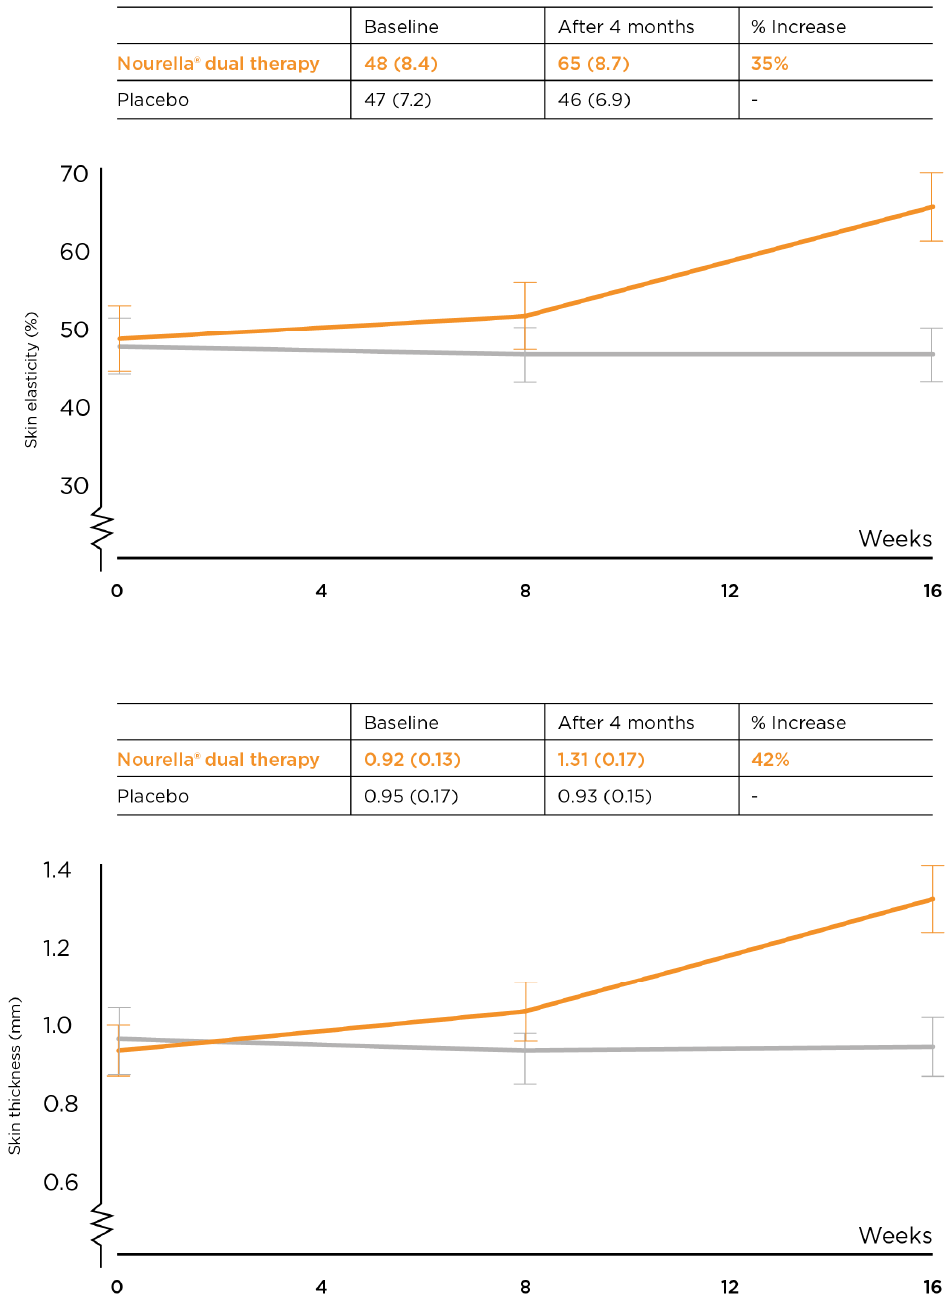
Figure 3. Mean skin elasticity ( up ) and thickness index ( down ) (measured objectively on both sides of the face in duplicates) in 60 individuals randomly assigned at a 1:1 ratio to receive either oral proteoglycans plus topical nano-encapsulated retinoid or placebo after 8 and 16 weeks; error bars represent SD [43].